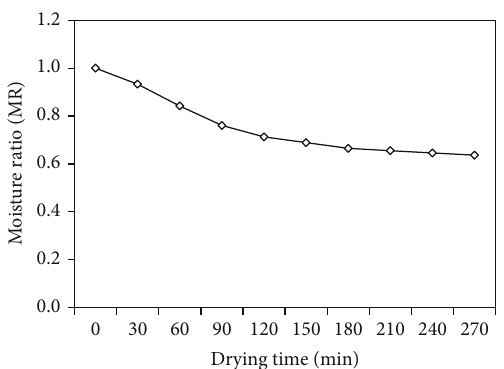
Figure 8: Variation of temperatures and relative humidity at the inlet and outlet of the drying section with drying time.